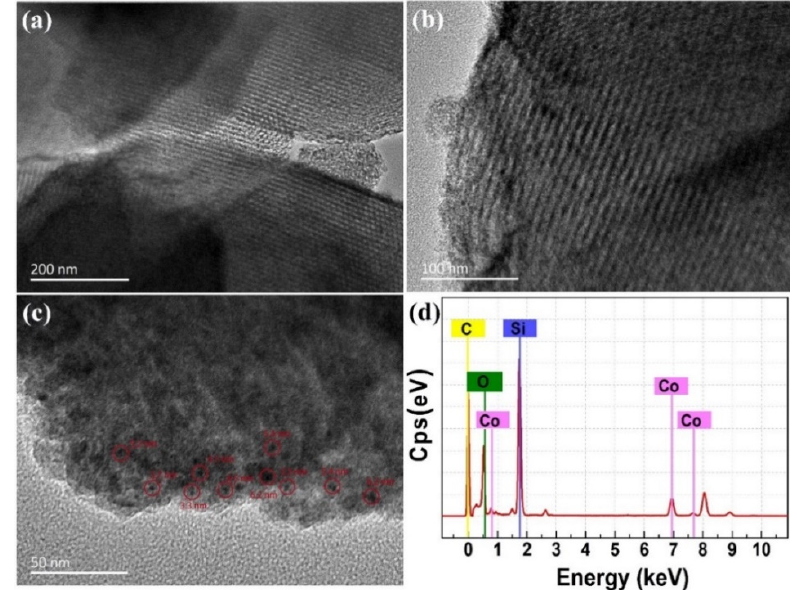
Figure 3. High resolution TEM ( a,b ), TEM of the sample exposed at prolonged electron beam ( c ) and EDS results ( d ) of the mesoporous Co ‐ SiO 2 (0.17) catalyst.